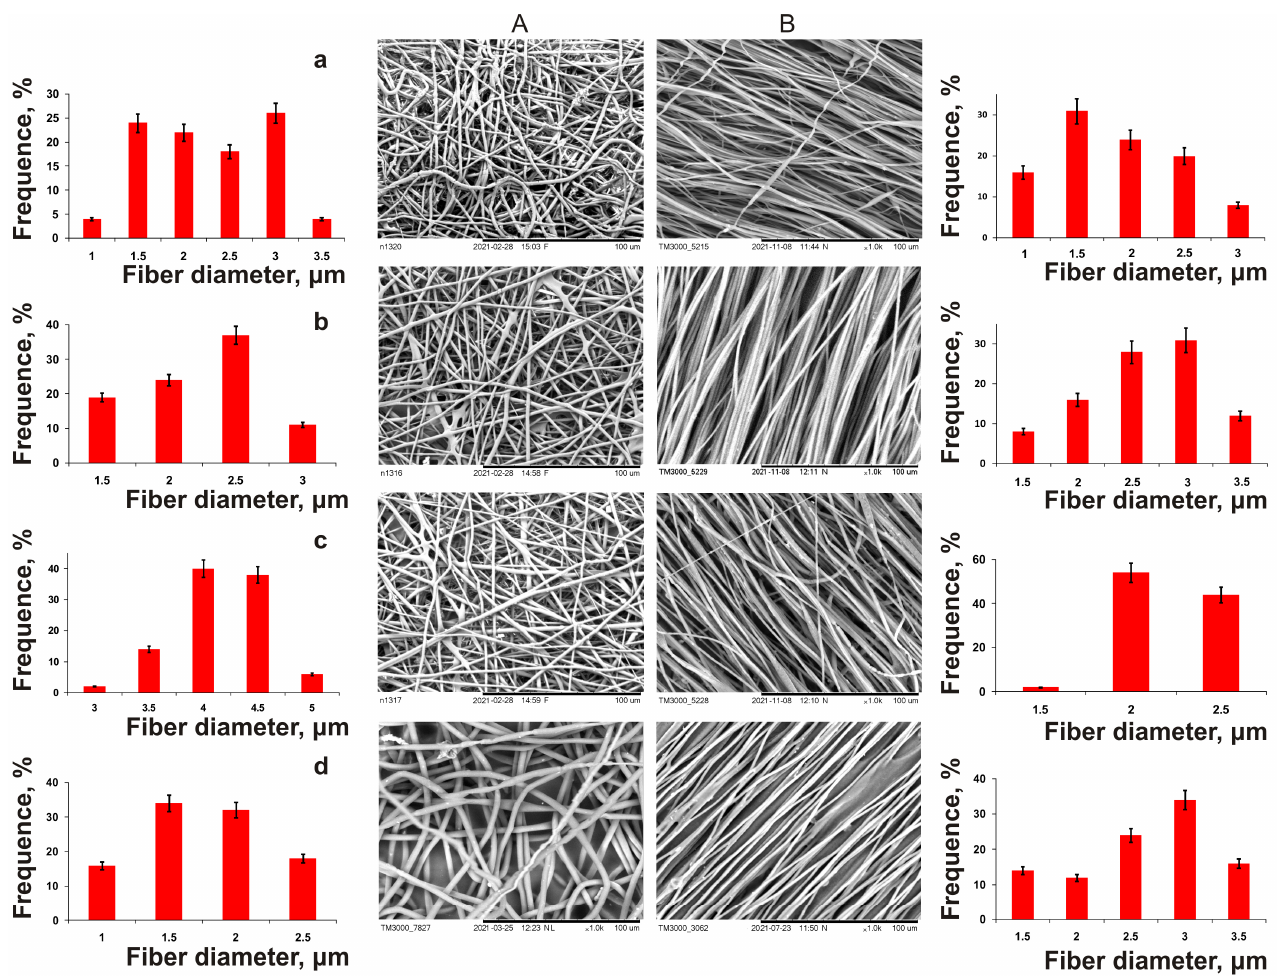
Figure 5. SEM images of randomly oriented ( A ) and aligned nanofibers ( B ) produced by electro- spinning from solutions of PHAs with different chemical compositions: ( a )—P(3HB); ( b )—P(3HB-co-